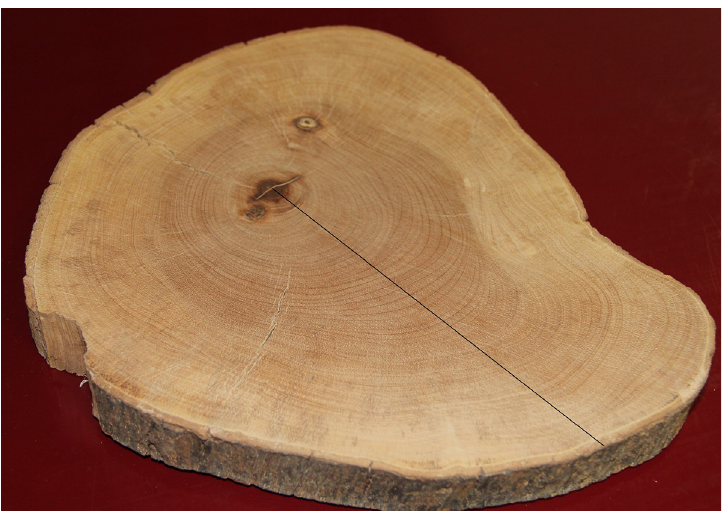
Fig 1. Cross-section of the bole of a tree, with observable tree rings (a tropical hardwood from near Coatzacoalcos, Veracruz, Mexico). Increment cores, such as the one in Fig 2, are taken with an increment borer from the bark towards the tree´s center (for example, along the black line), without destroying or severely harming the tree.